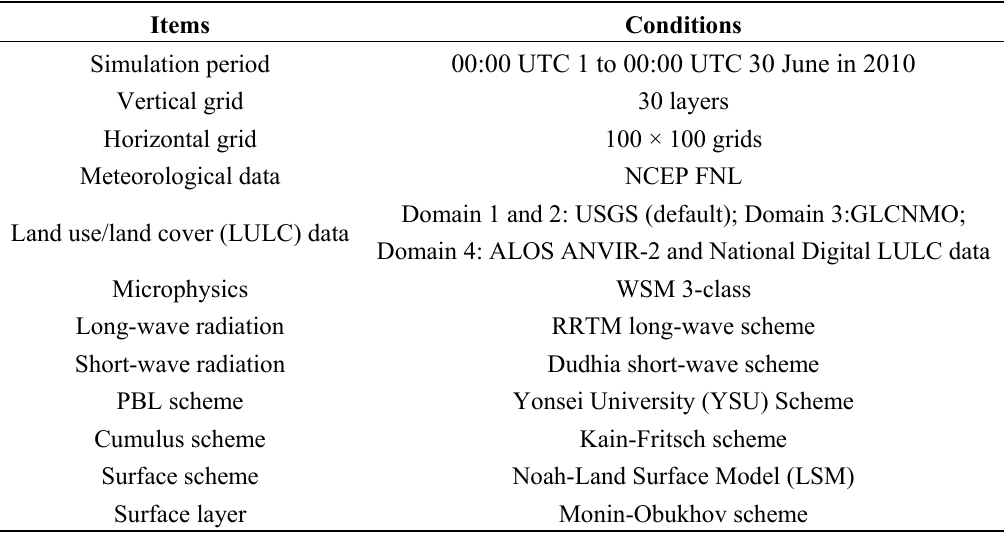
Figure 4. Comparison between the observed and simulated value for ( a ) air temperature; ( b ) wind speed; ( c ) wind direction at Lang station located in Hanoi city center. Table 2. WRF Simulation